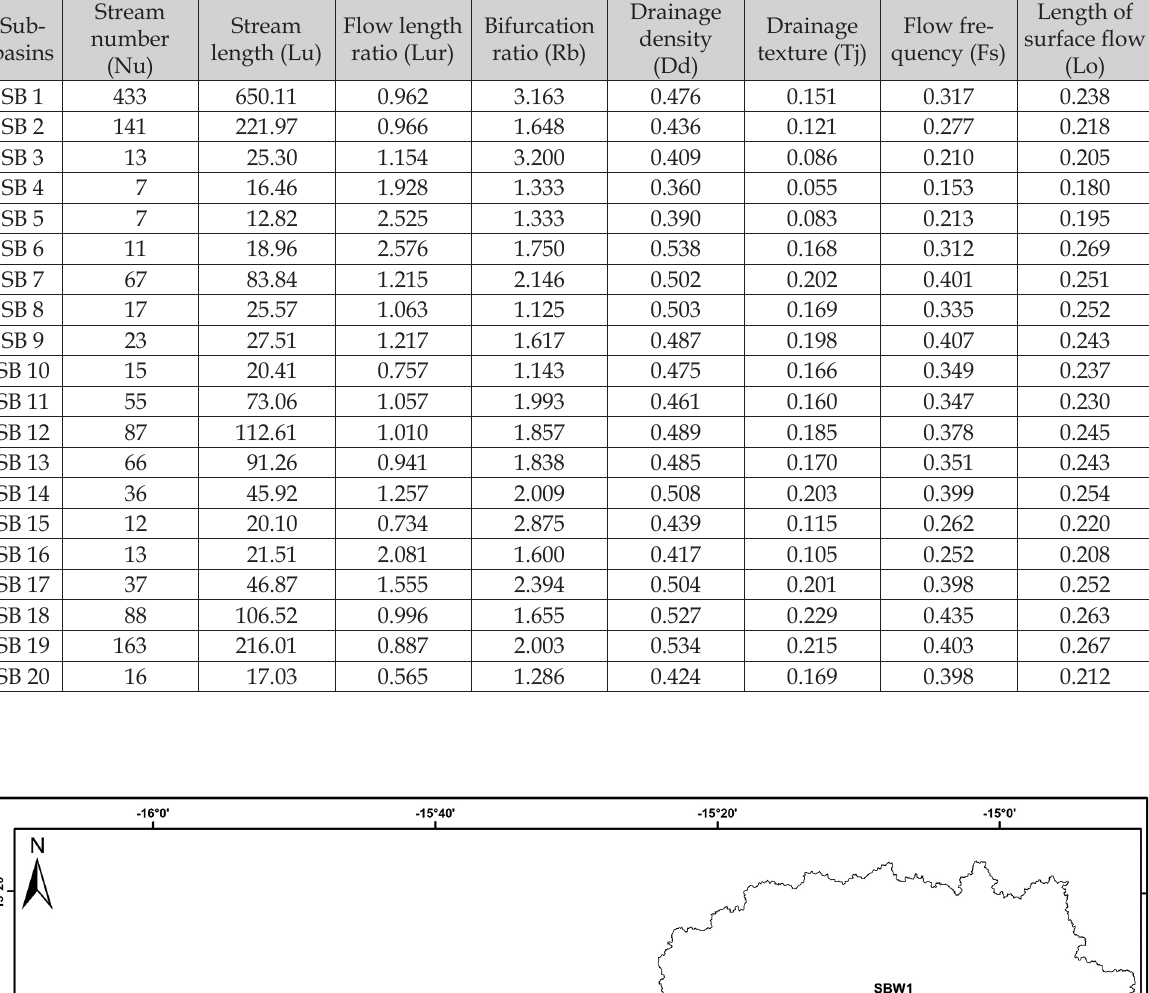
Table 3. Linear parameters of the sub-catchments of the Soungrougrou catchment.